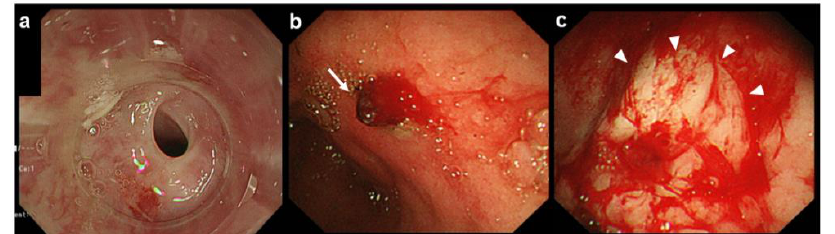
Figure 2. Esophageal stenosis and injection therapy by hypertonic saline-epinephrine (HSE) solution via TNE for the initial therapy. ( a ) First examination using a normal diameter scope showing esophageal stenosis; ( b ) TNE examination showing the source of the bleeding at the antrum of the stomach (arrow); ( c ) the bleeding lesion after HSE therapy. The mucosa around the lesion turns white after HSE injection (arrowheads) after successful hemostasis.